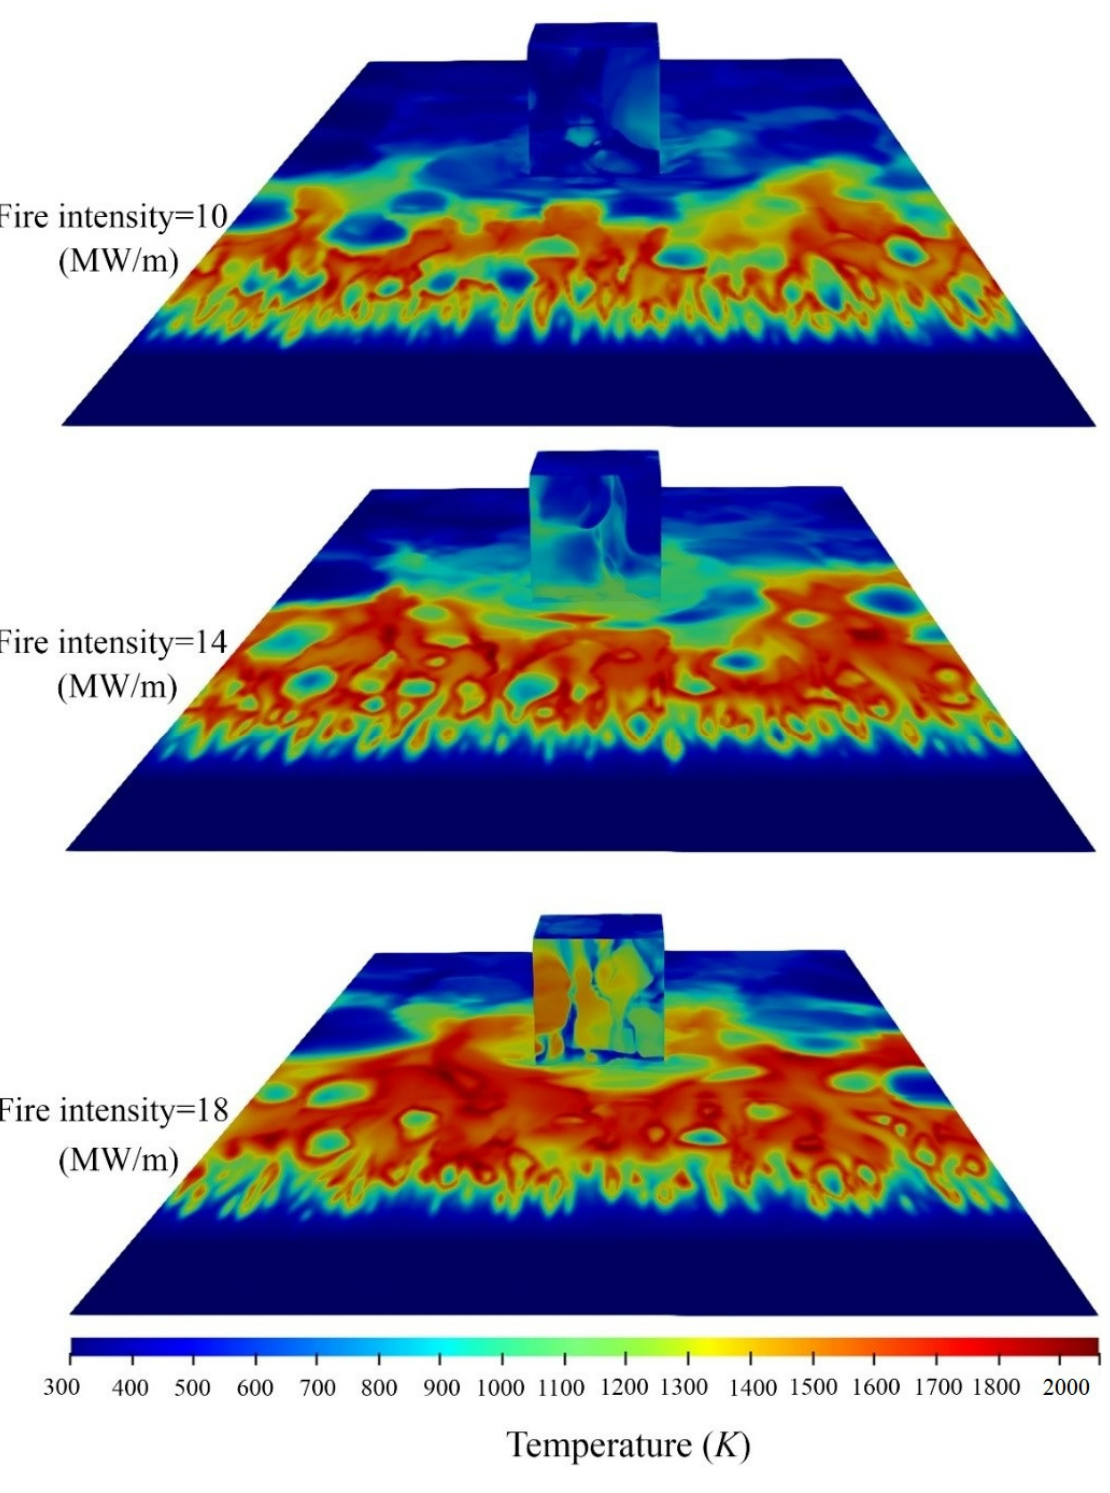
Figure 7. Temperature distribution on the ground in a constant U ref = 6 m/s and three different fire